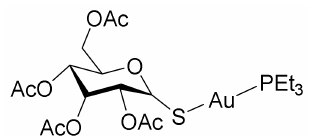
Figure 1. Structure of